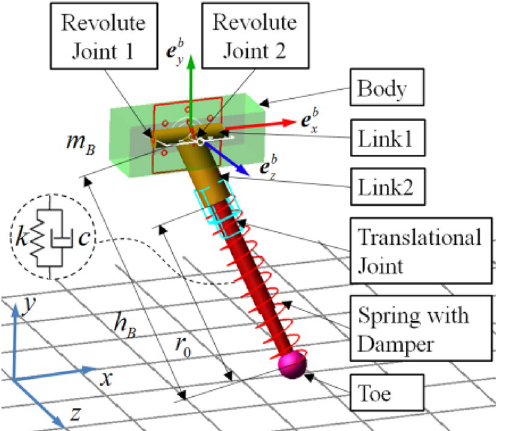
Figure 9. Simulation model of the 3D-SLIP running system in ADAMS.